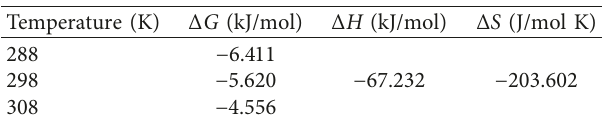
Figure 9: Fitting curves of the Freundlich model (a) and Langmuir model (b). Table 4: Thermodynamic parameters for the adsorption of CHE on ZSM-5 at different